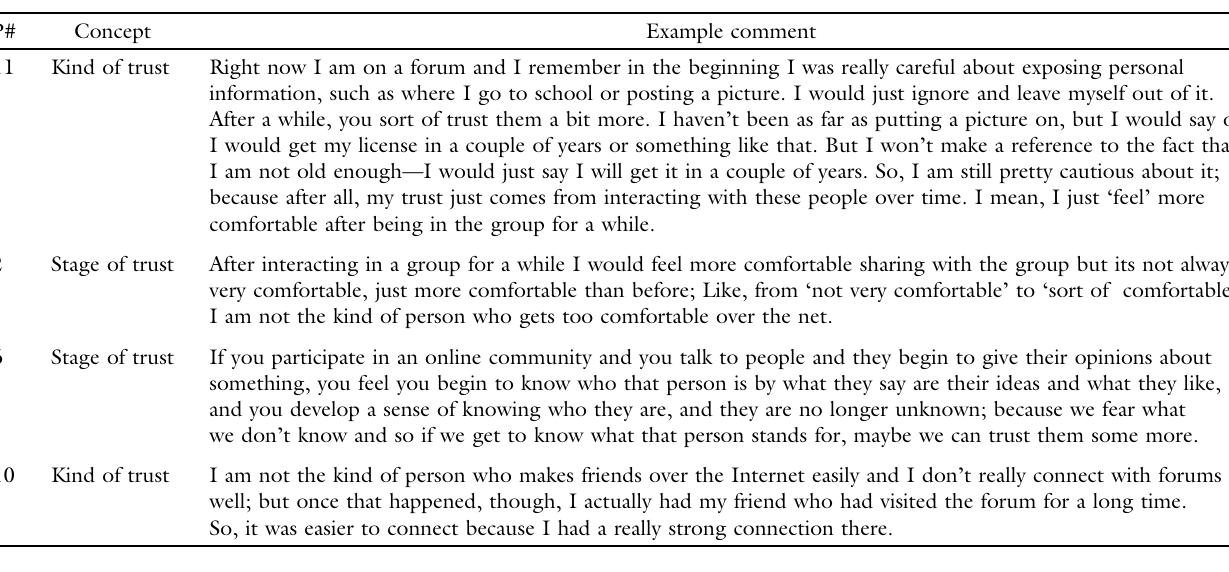
Table 5. Sample user quotes on privacy factors—trust.